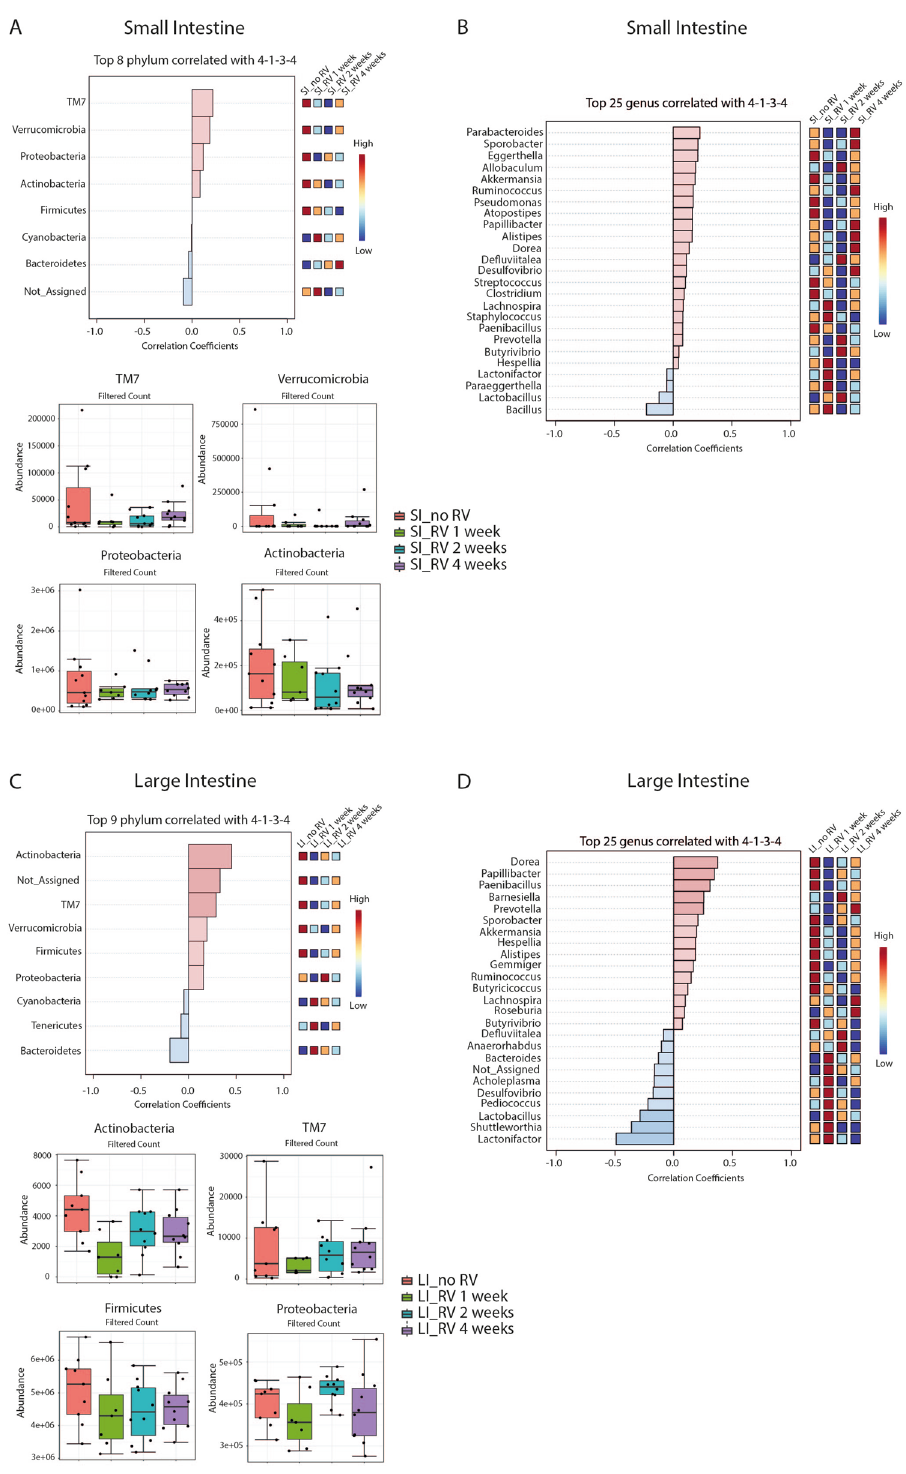
Figure 2. Important features identified by Pattern search using correlation analysis. The features are ranked by their correlation, and the light blue bars represent negative correlations, while light red bars represent positive correlations. To the right is a mini-heatmap showing whether the abundance of that features is higher (red) or lower (blue) in each group. ( A ) Important features from the SI niche at the Phylum level. ( B ) Important features from the SI niche at the Genus level. ( C ) Important features from the LI niche at the Phylum level. ( D ) Important features from the LI niche at the Genus level. Results are from a total of 76 intestinal samples (38 from SI and 38 from LI) from two independent